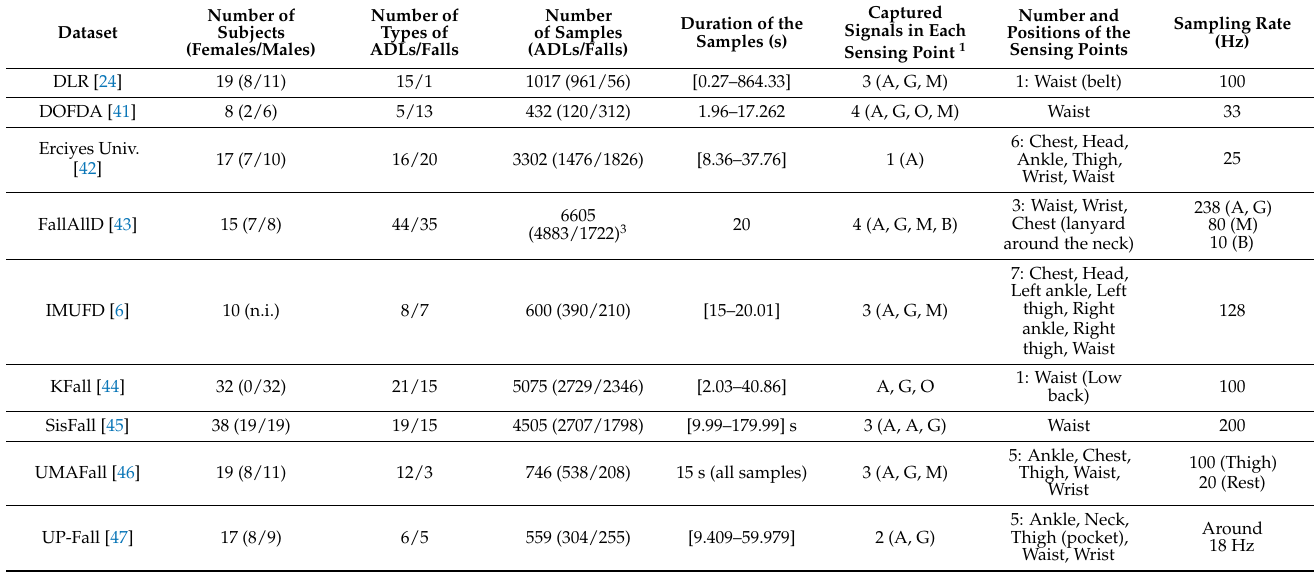
Table 2. Basic data of the employed